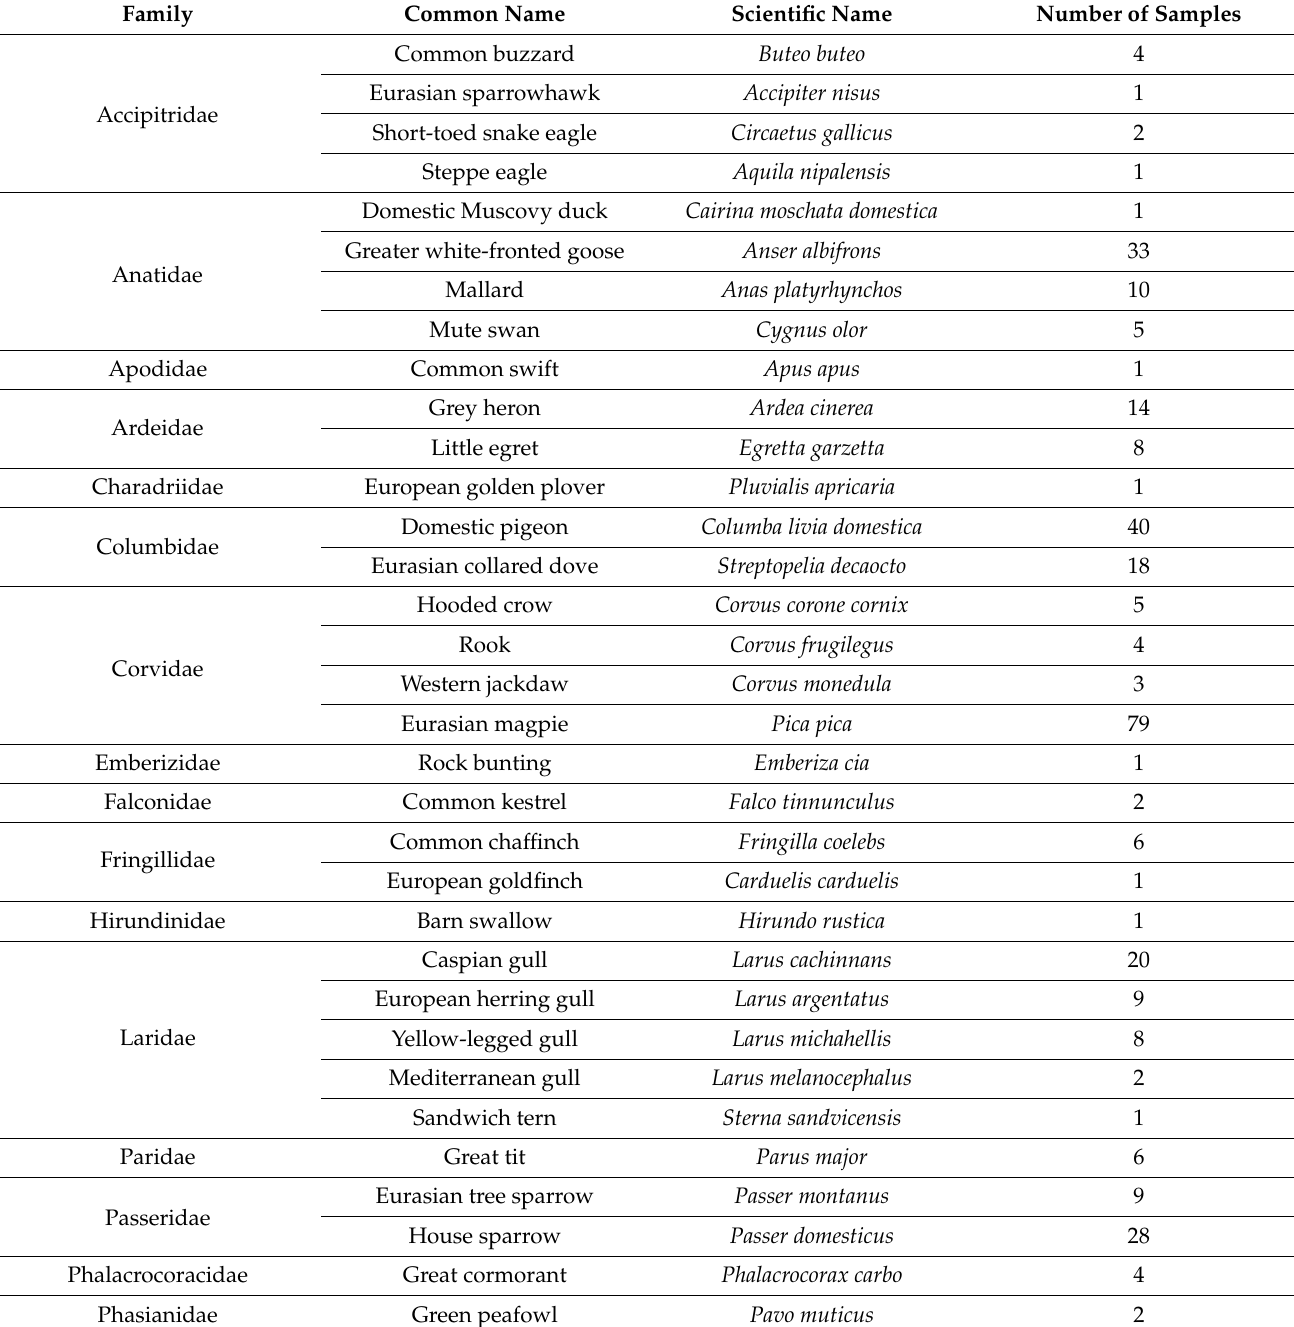
Table 1. Number of samples per wild or feral bird species collected and